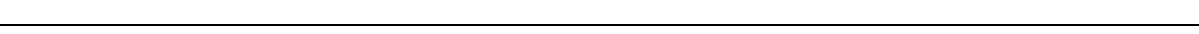
Fig. 4 PIF5 directly represses the expression of MIR156 genes. a Transient expression assays shows that PIF5 directly represses the expression of MIR156B , MIR156D , MIR156E , MIR156F , and MIR156H . Representative images of N. benthamiana leaves 72 h after in fi ltration were shown. b Quantitative analysis of luminescence intensity in a . Five independent determinations were assessed. Values shown are mean ± SD ( n = 5). ** P < 0.01 by the Student ’ s t -test. c Dual-luciferase assay of pMIR156::LUC expression. The expression of REN was used as an internal control. LUC/REN ration represents the relative activity of the MIR156 promoter. Values given are mean ± SD ( n = 3). ** P < 0.01 by the Student ’ s t -test. d Transcript levels of mature MIR156 analyzed by qRT-PCR. Eight-day-old WT, PIF overexpressors, and pifq seedlings grown under WL were harvested for RNA extraction. Values given are mean ± SD ( n = 3). * P < 0.05 and ** P < 0.01 by the Student ’ s t -test. e The relative expression levels of individual primary MIR156 in 8-day-old WT, PIF overexpression, and pifq seedlings grown under high R:FR conditions. Values given are mean ± SD ( n = 3). * P < 0.05 and ** P < 0.01 by the Student ’ s t